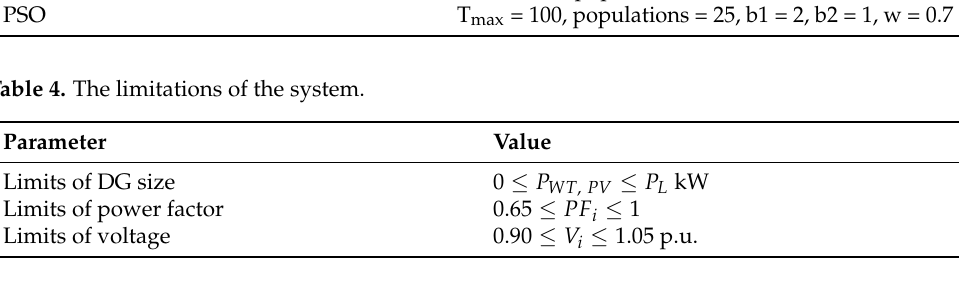
Table 5. Characteristics of the generation